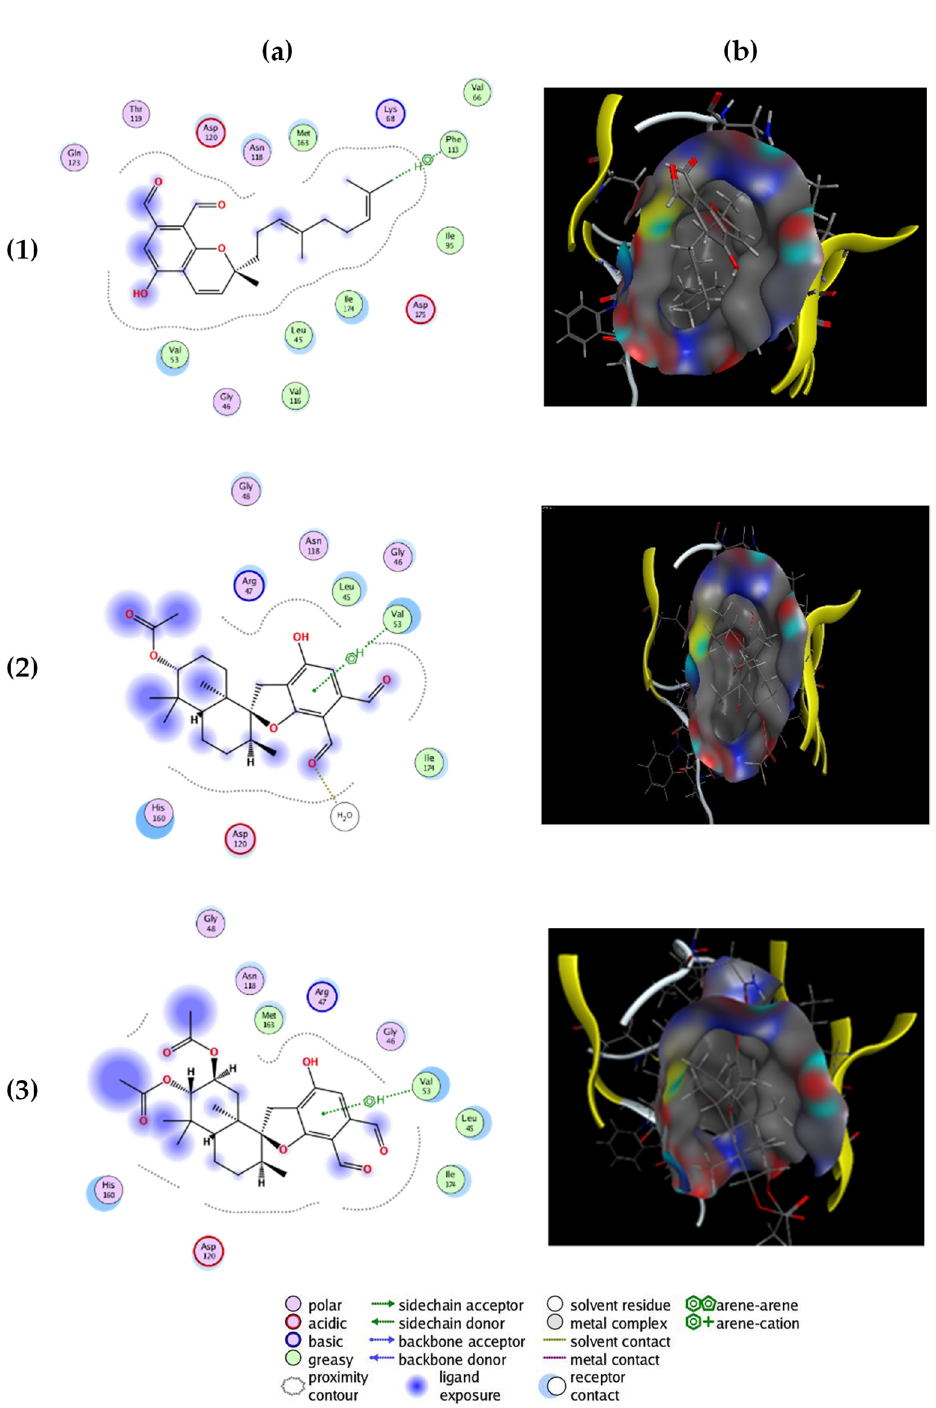
Figure 2. ( a ) Two-dimensional interaction between the three best compounds and the ATP binding site and ( b ) snapshots representing the three-dimensional docking complex of the selected com- pounds with the binding site of CK2: (1) stachybotrychromene C, (2) stachybotrydial acetate and (3) acetoxystachybotrydial acetate.